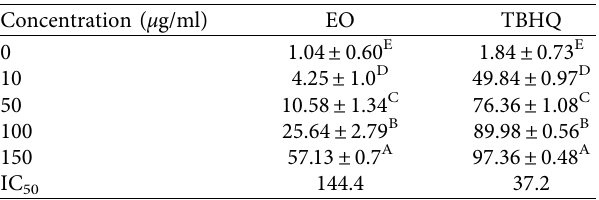
Table 2: The antioxidant activity of Z. multiflora essential oil and TBHQ.